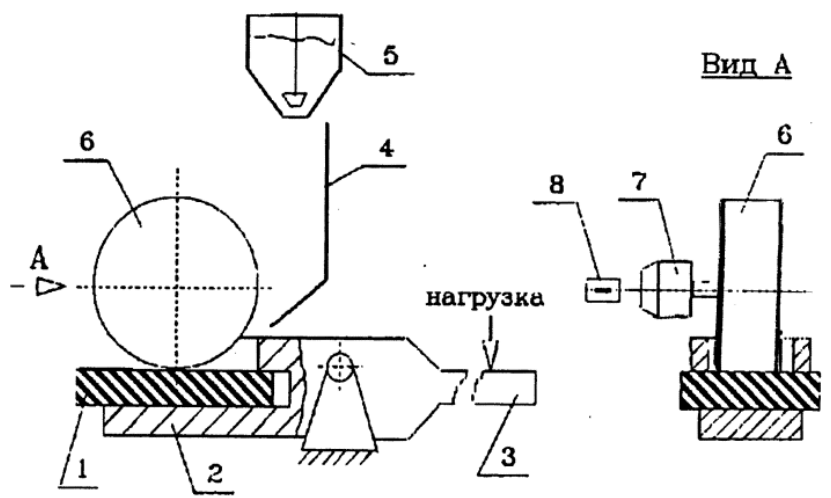
Figure 1. Equipment for wear testing: 1: sample; 2: sample holder; 3: lever; 4: guide tray; 5: measuring hopper; 6: roller; 7: drive; 8: counter of roller turns.